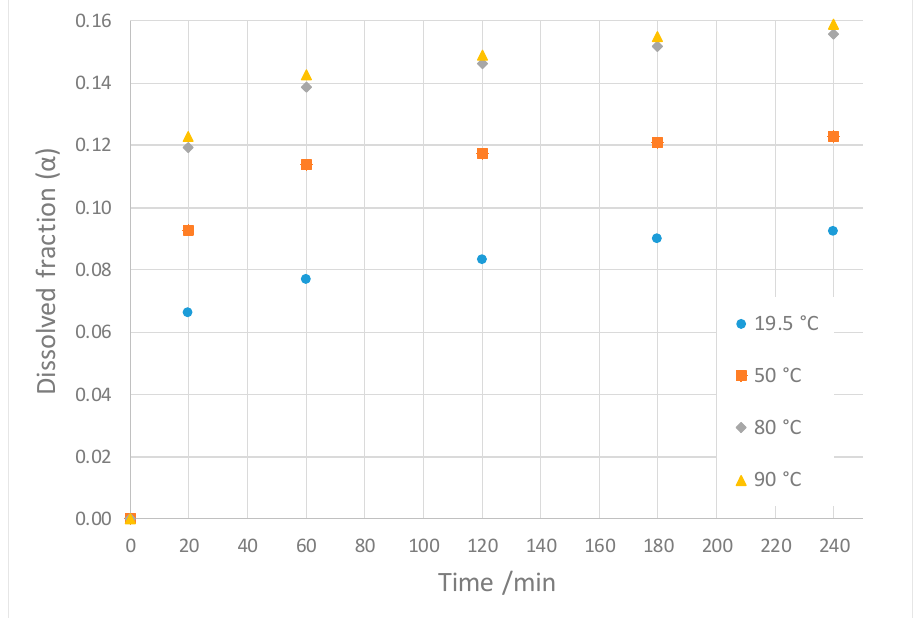
Figure 1. Kinetics of chalcopyrite dissolution in terms of dissolved fraction at different temperatures: 19.5 °C (circles), 50 °C (squares), 80 °C (diamond), 90 °C (triangles). Molar liquid to solid ratio: 9.88.